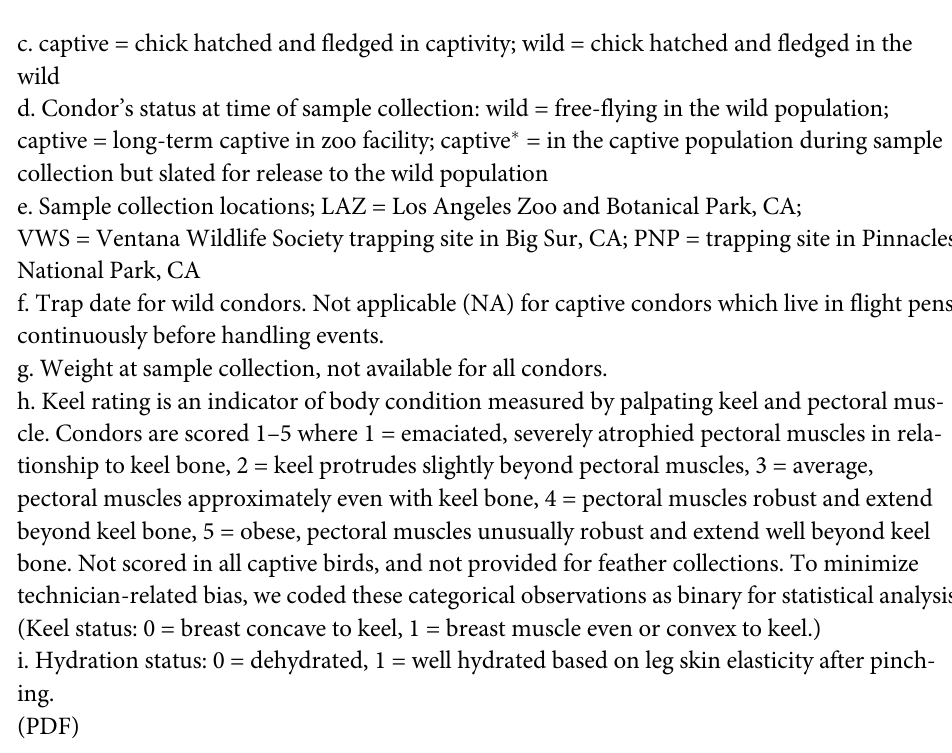
S2 Table. Details for California condor feather sections. a. Feather position code: R/ L = right/left, P = primary, # = primary feather position, “retrix” = tail feather of